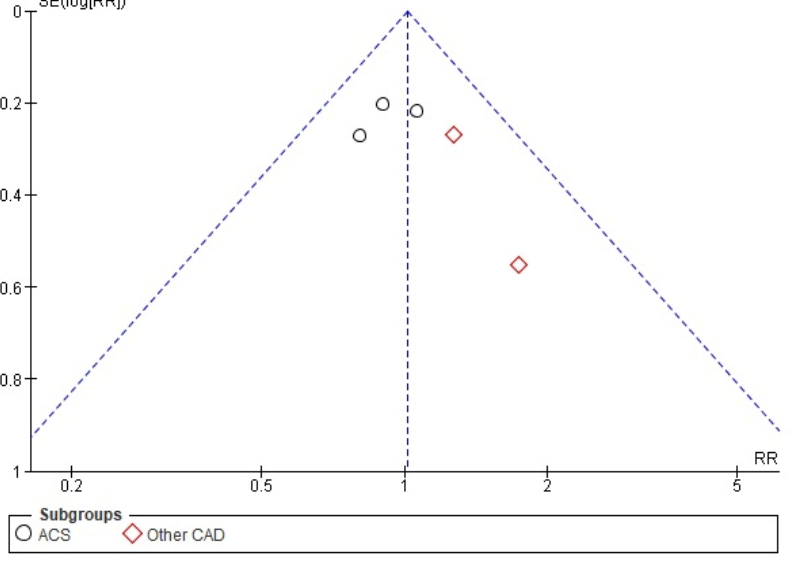
Figure 2. Publication bias of MACE RR in all RCTs at 1-year follow-up: funnel plot.